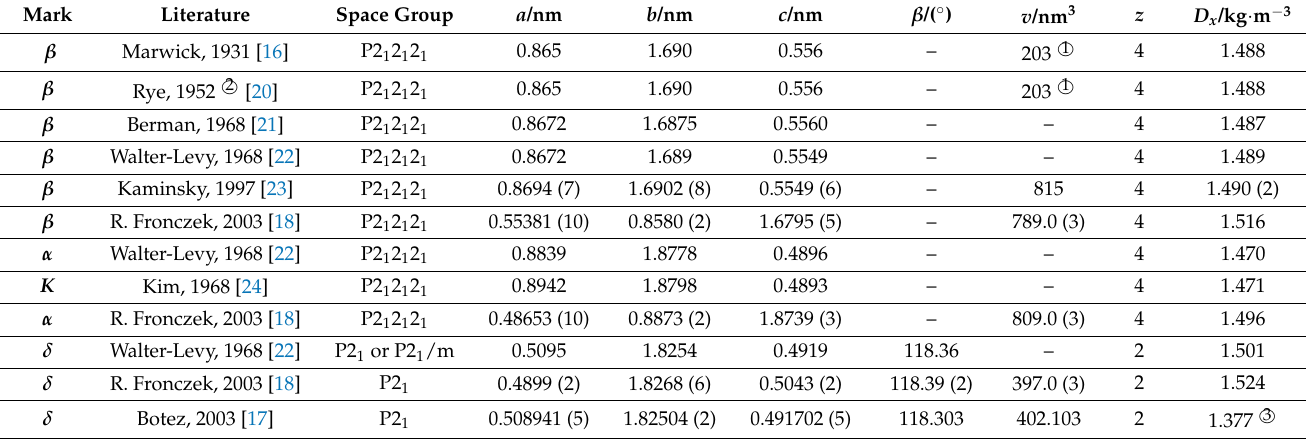
Figure 2. Intermolecular interactions in different crystal cells of D -mannitol polymorphs. ( a ) α , ( b ) β , and ( c ) δ . Reprinted from Ref. [19]. Copyright 2020, with permission from Elsevier. Table 1. The review of unit cell parameters and nomenclature of D -mannitol anhydrous polymorphs in the literature. Reprinted from Ref. [15] . Copyright 2017, with permission from Elsevier.